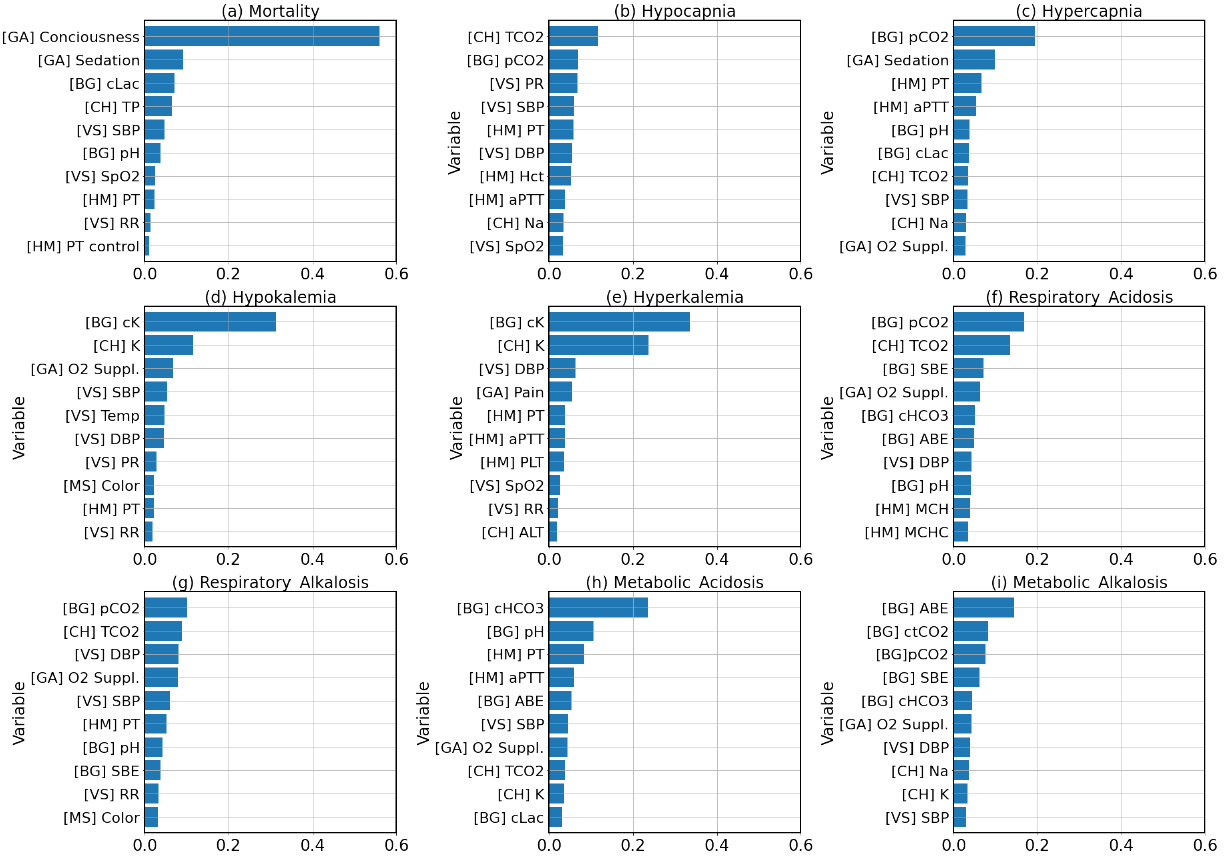
Figure 6. Feature importances calculated from the GB classifer for each clinical